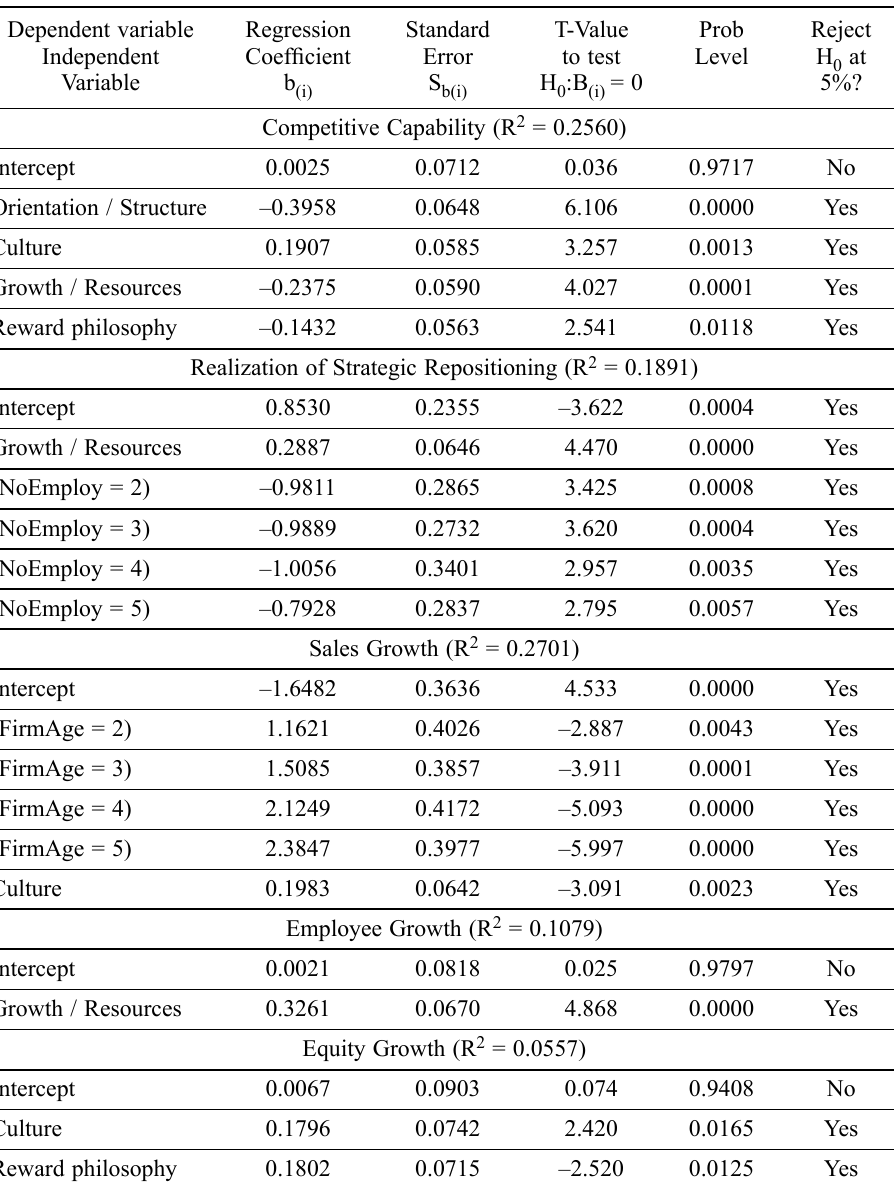
Table 5. Regression equation